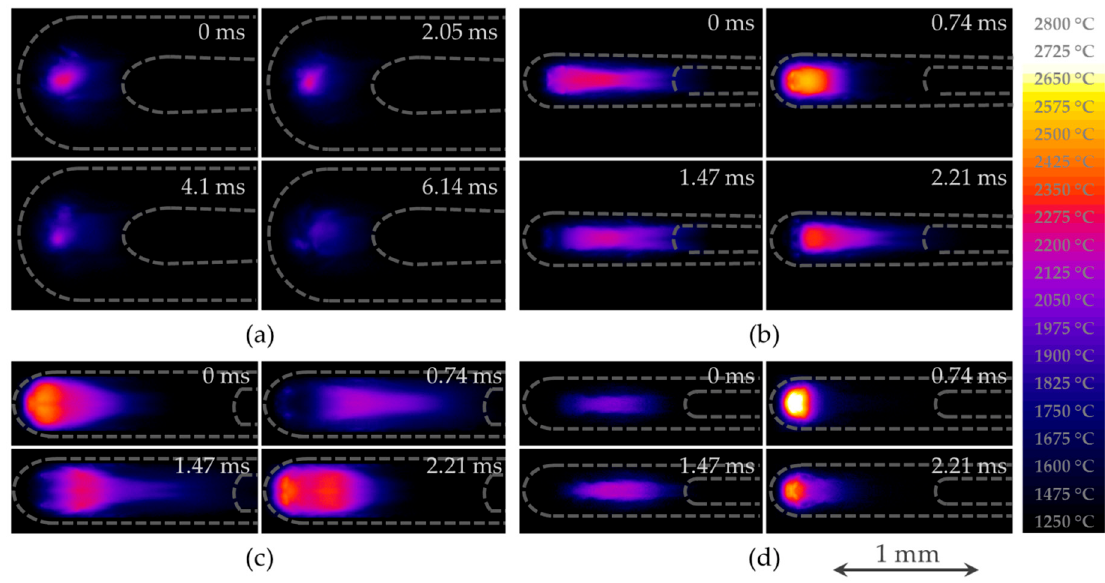
Figure 13. Sequence of four measurement moments for temperature distribution T i,j (t) calculated with e = 1 of 12 mm stainless steel cut with the following parameters: ( a ) Set #1: Static beam shaping with 488 fps; and different values of the longitudinal, linear beam oscillation parameters with 1360 fps; ( b ) Set #2: 300 µm amplitude and 500 Hz frequency; ( c ) Set #3: 550 µm amplitude and 500 Hz frequency; ( d ) Set #4: 300 µm amplitude and 2000 Hz frequency.